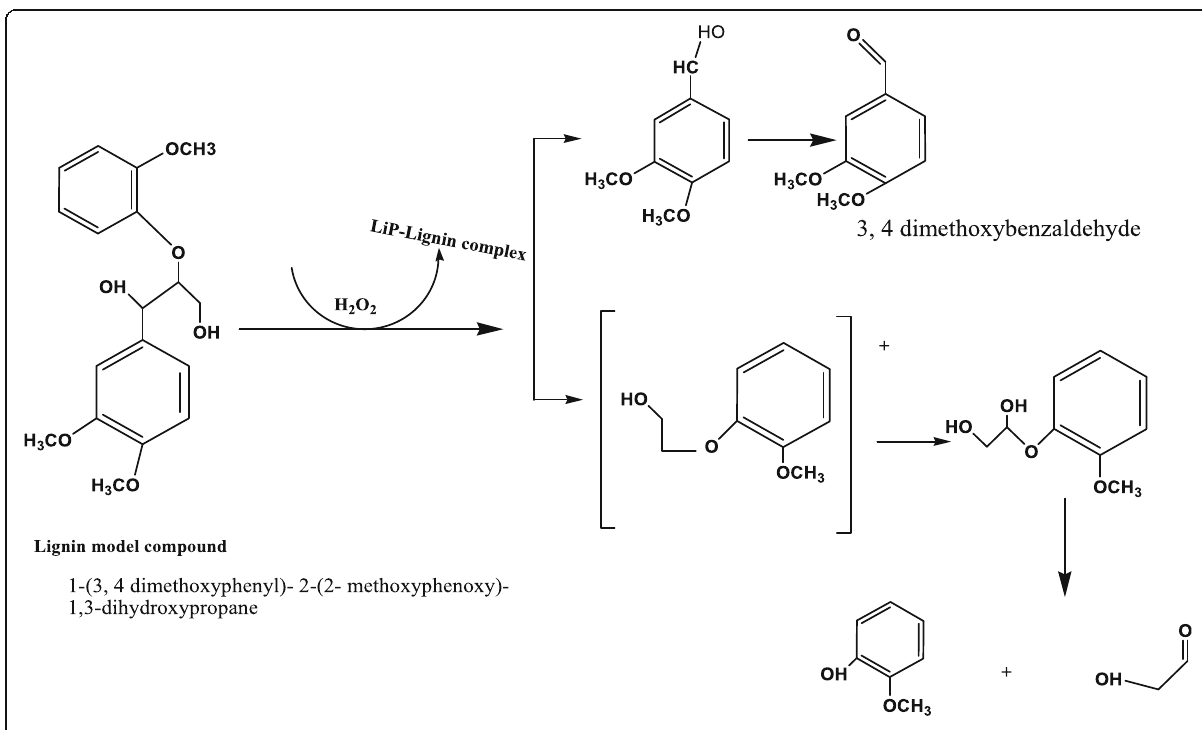
Fig. 2 Lignin peroxidase-catalyzed oxidation of lignin model compound (veratrylglycerol beta-guaiacyl ether)